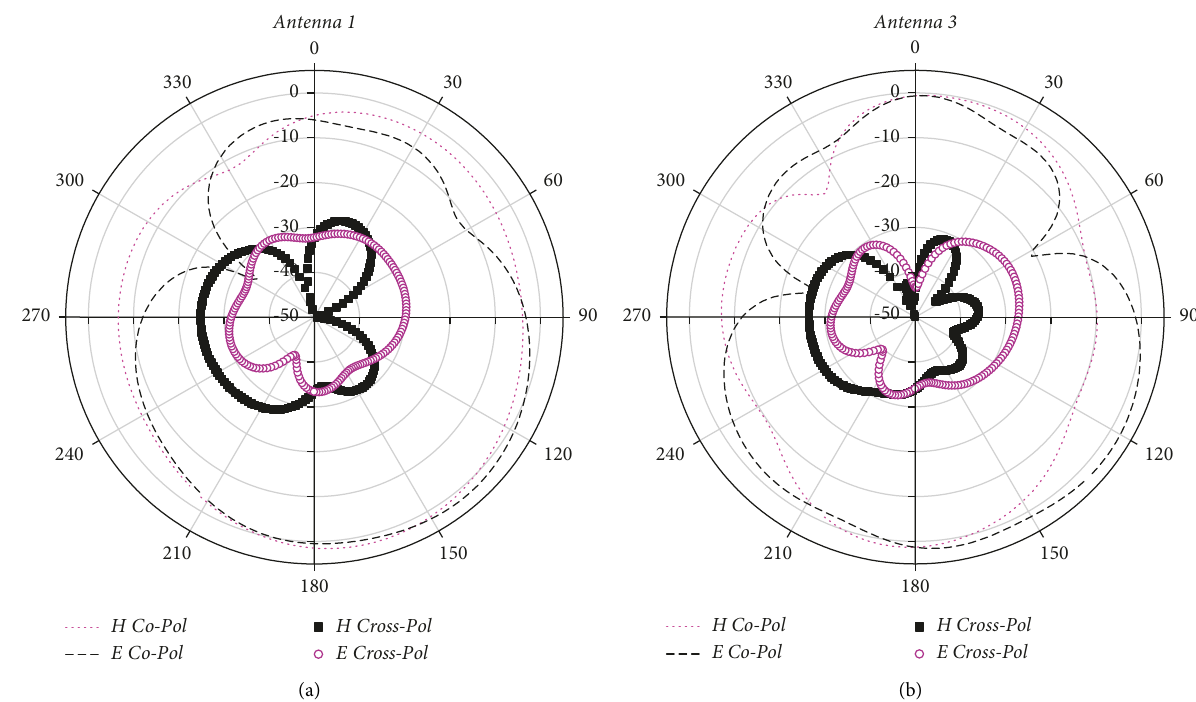
Figure 16: Measured radiation patterns of antennas 1 and 3 at 35GHz.